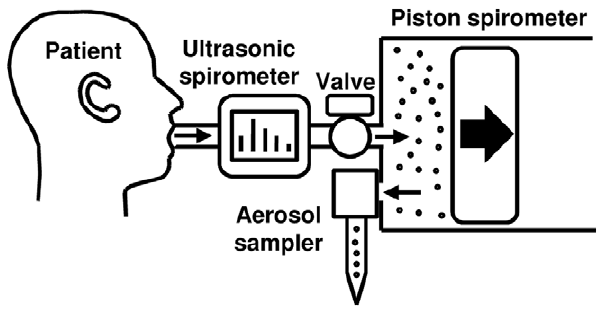
Figure 3. Cough aerosol particle collection system. Before each test, the piston spirometer was purged and partially filled with 5 liters of clean dry air. When the patient coughed into the system mouthpiece, the cough flowed through an ultrasonic spirometer which measured the cough volume and flow rate. The cough then flowed through a valve and into the piston spirometer, displacing the piston to the right. When the subject finished coughing, the valve was closed and the aerosol sampler was turned on. The cough aerosol was pulled out of the spirometer and collected by the aerosol sampler. As the aerosol sampler drew air, the piston moved to the left until no air remained in the spirometer.